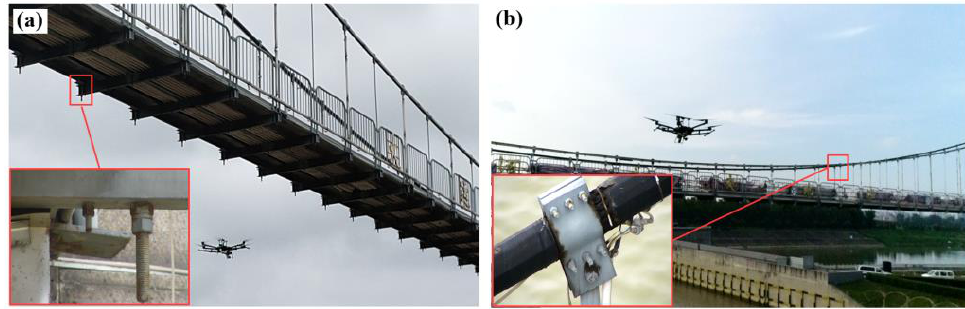
Figure 13. Test process of bolt inspection using UAS for ( a ) bridge bottom and ( b ) cable clamp.